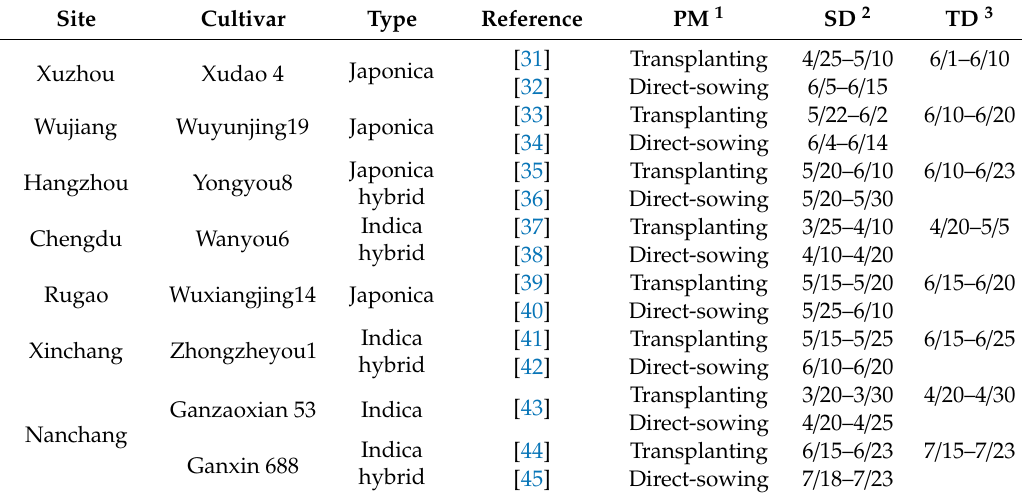
Table 4. Sowing and transplanting dates recommended by local agricultural